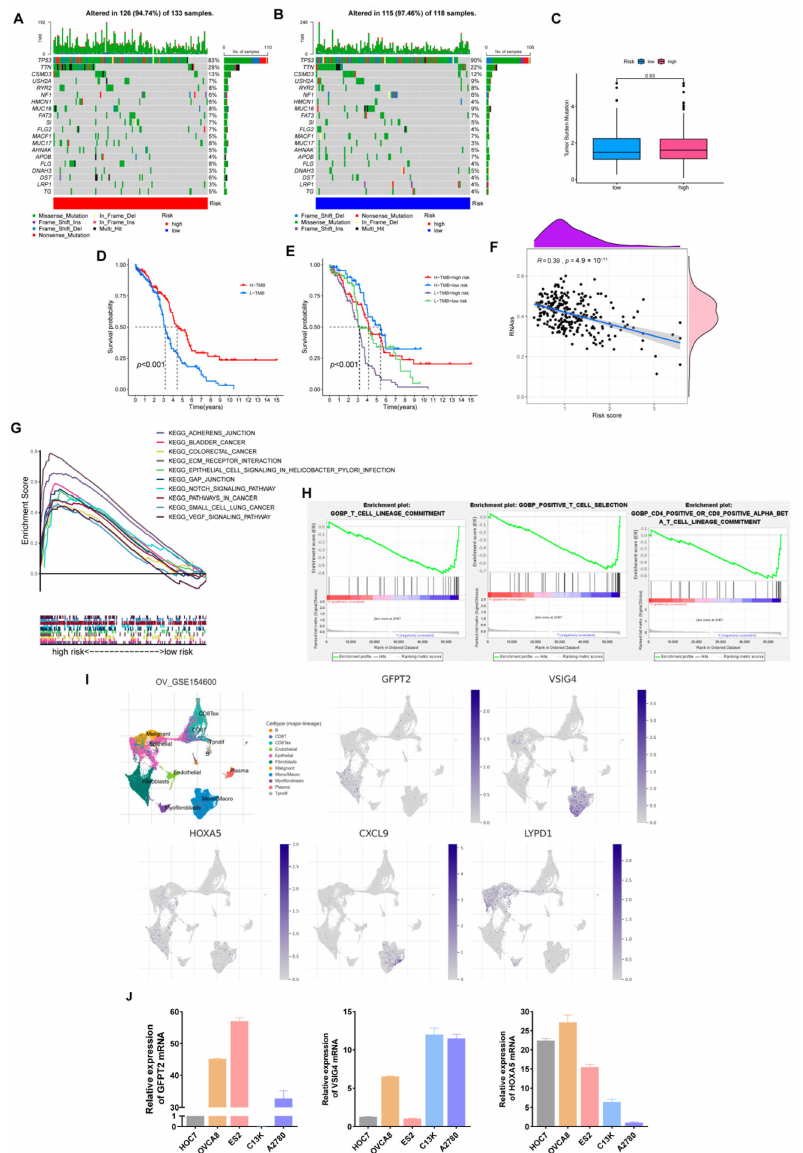
Figure 8. Comprehensive analysis of the risk model in OV. ( A , B ) Somatic mutation landscape in different risk sets. ( C ) TMB comparison of two groups. ( D , E ) Relevance of TMB and risk scores to prognosis. ( F ) Correlation of risk scores and Stemness Scores. ( G ) KEGG pathways enriched in the high-risk set. ( H ) GO-BP enrichment results in the low-risk cohort. ( I ) The expression of five hub genes is based on GSE154600. ( J ) Verification of three hub genes’ expression in ovarian cancer cell